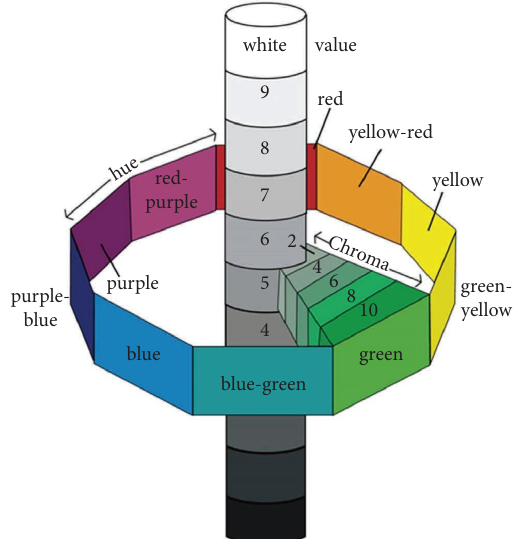
Figure 2: Munsell color system (adapted and redrawn from ©1994 Encyclopedia Britannica,